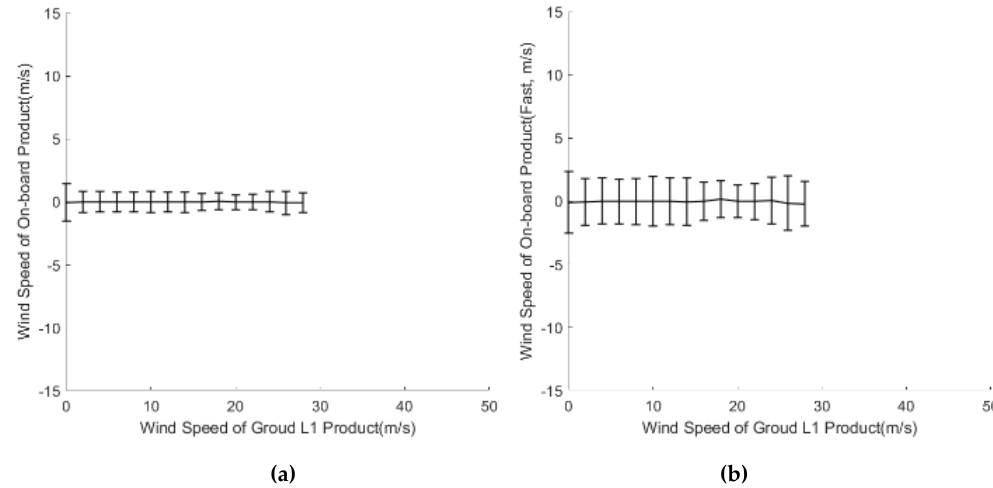
Figure 11. Mean differences and error bars of the ground L2 product wind direction and on-board wind directions derived from a full GMF LUT ( a ) and a desampled GMF LUT ( b ).